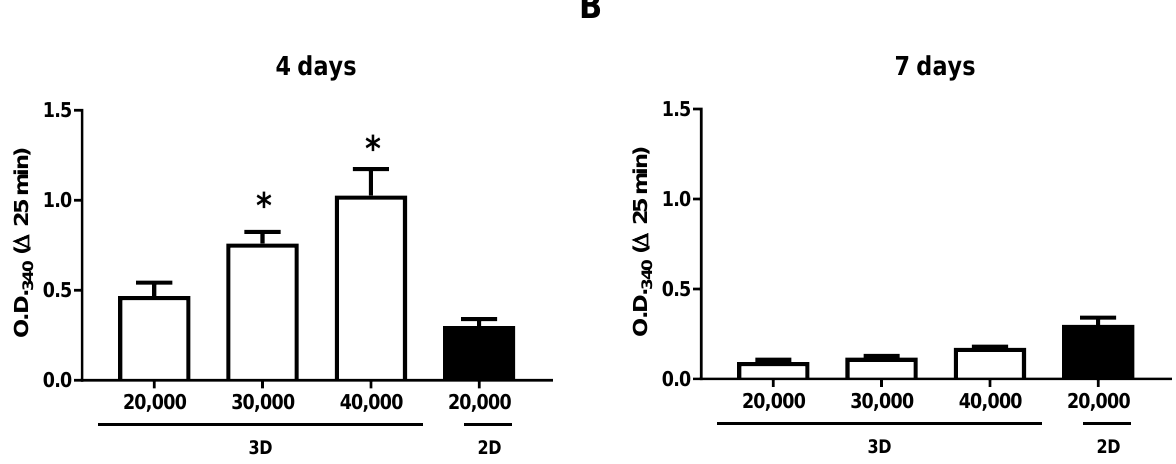
Figure 8. LDH test of aggregates with 4 days ( A ) and 7 days ( B ) of formation. All groups were significantly different in the same experimental time. Bars represent the mean ± SD (n = 5) reduction in optical density at 340 nm after 25 min reaction. Black bars indicate the results obtained with monolaminar cell culture of MC3T3-E1 cells form the same origin as those used in the aggregates. An asterisk indicates significant differences from other groups in the same experimental time ( p < 0.05).